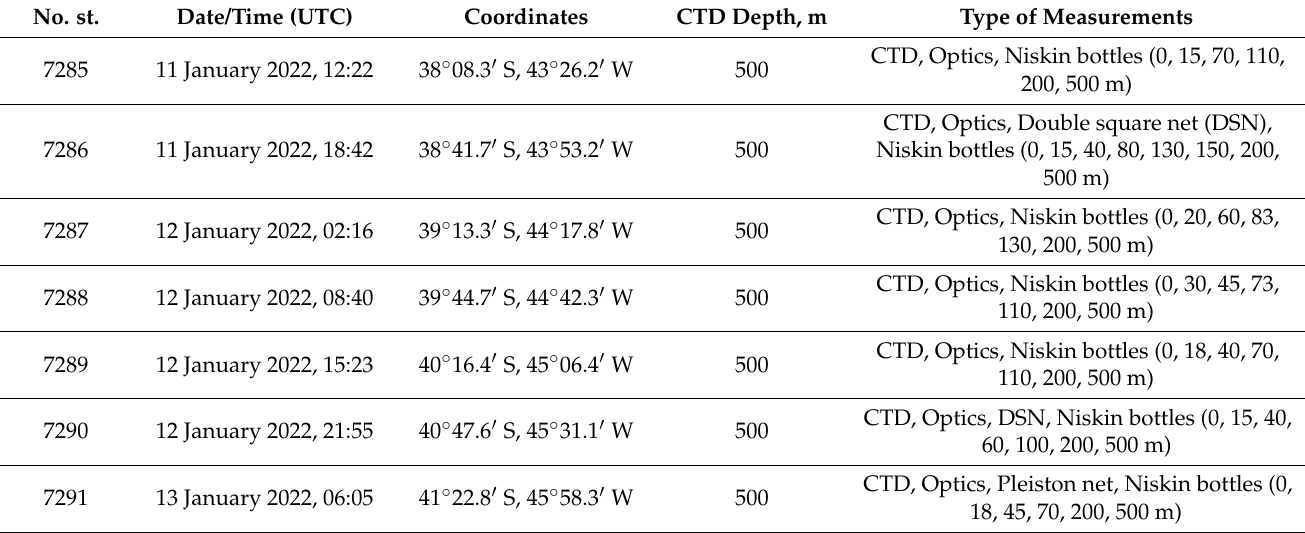
Table 1. Location, time, and type of measurements at seven stations between centers of cyclonic and anticyclonic rings in the Southwest Atlantic performed on 11–13 January